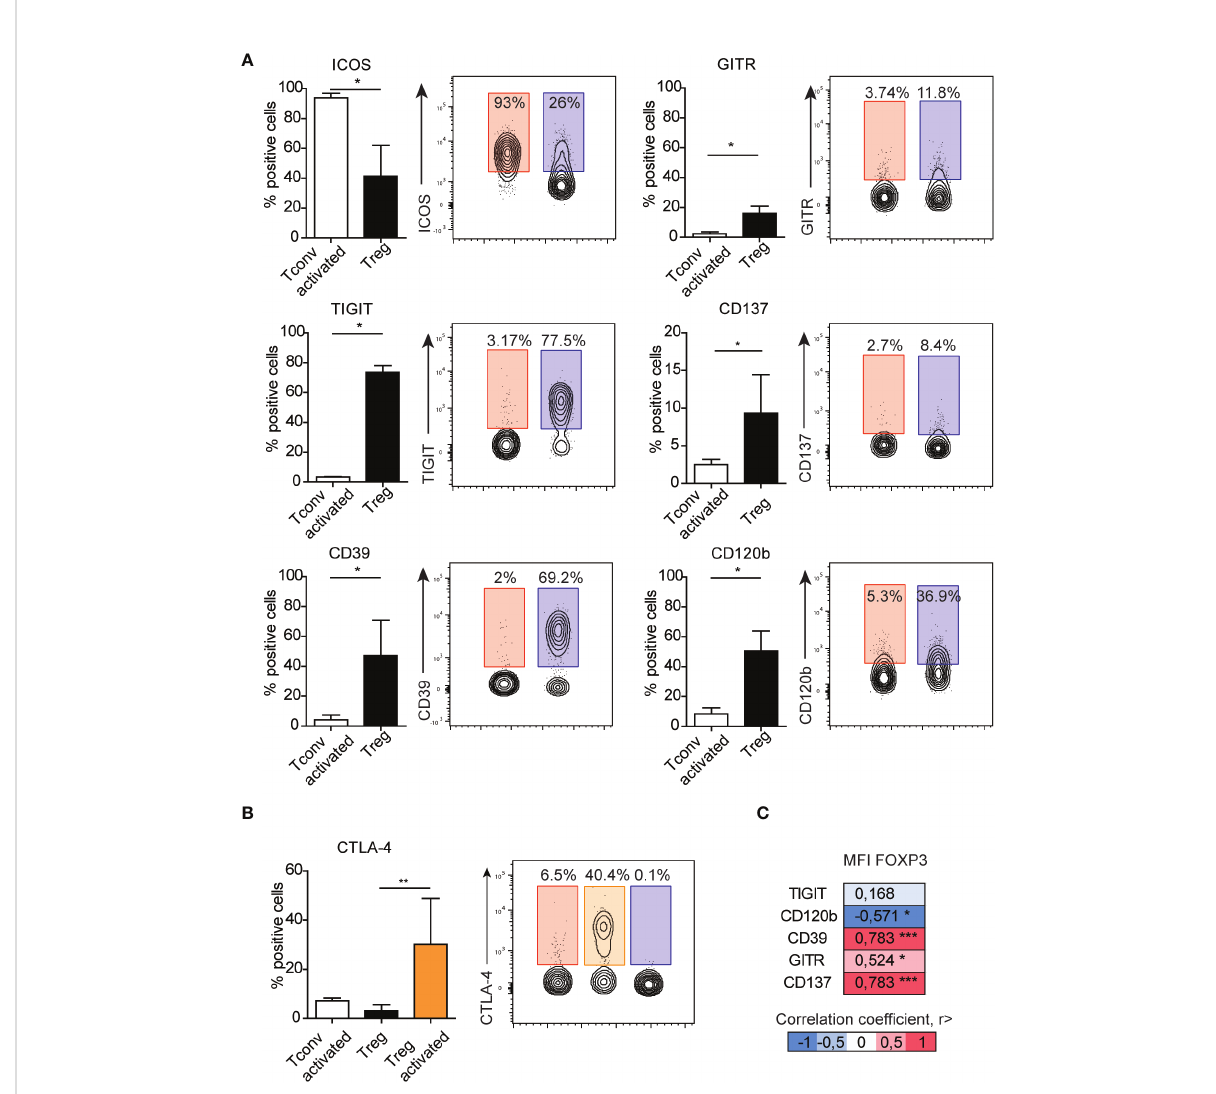
FIGURE 4 Surface expression of GITR, TIGIT, CD137, CD39, or CD120b distinguish activated Tconv from Treg cells. (A) The impact of activation on the expression of surface markers on Tconv (n=3) cells and comparison with those on Treg cells (n=5). (B) The impact of activation on the expression of CTAL-4 on Tconv (n=5) and Treg (n=5, n=3 activated Treg) cells. (C) Correlation between the median fl uorescence intensity of FOXP3 and Treg-related surface markers. Numbers adjacent to gates on contour plots indicate percent gated cells as positive for the given surface marker (blue – Treg, red – activated Tconv, orange – activated Treg cells). To compare Treg and Tconv cells, plots were made by the concatenation function by FlowJo. Data represent the mean ± SD. *P ≤ 0.05, **P ≤ 0.01 and ***P ≤ 0.001 (Mann Whitney test (A) , Kruskal-Wallis test (B) , Spearman correlation (C)